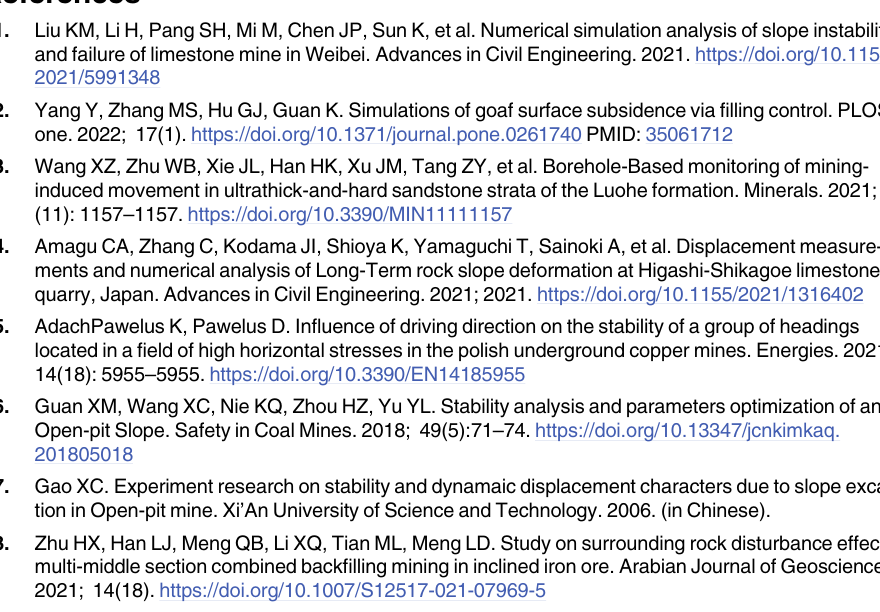
S1 Fig. Schematic diagram of the excavation effect. The essence of excavation effect is to remove the load in one or two directions from the slope originally in the three-way stress state and change its original stress state. S2 Fig. Stress distribution during excavation of rock-soil slope. The solid line refers to prin- cipal stress trace, red dotted line refers to shear stress trace. The stress variation characteristics in the figure are as follows: (1) As the excavation goes on, the stress changes increase with the decrease of the distance from the excavation surface. (2) The shear stress zone is formed at the foot of slope, which is prone to